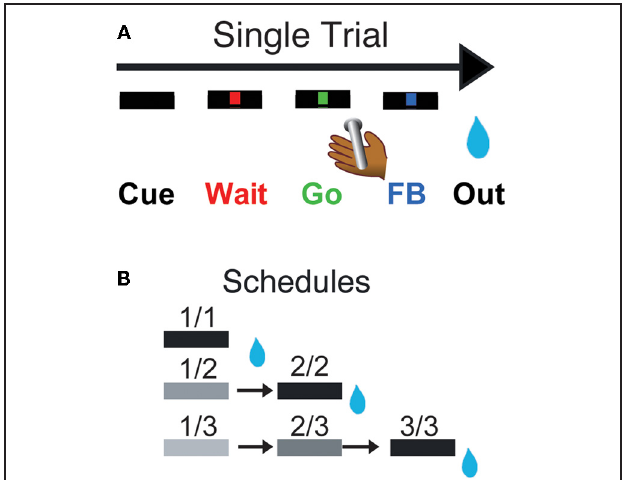
FIGURE 1 | Reward schedule task. Each individual trial (A) begins if the monkeys touch the bar. A cue (rectangle) appears on the monitor in front of them, followed by a red point (wait signal) after 500ms. When the point turns green (Go signal, within 500–1500 ms), the monkey must release the bar within 800ms to complete the trial correctly, in which case the point turns blue (feedback signal). The outcome (juice reward, or not, as a function of the schedule state) occurs 250–550ms later. In the reward schedule task (B) , monkeys must complete either 1, 2, or 3 correct trials to obtain the reward. Once a schedule is completed, another schedule is selected randomly out of the three possible lengths (1, 2, or 3 trials). The progression through the schedules is indicated by the brightness of the cue. All rewarded trials are indicated by a black cue. The fractions indicate the six schedule states, characterized by the trial number (numerator) and the schedule length (denominator). Monkeys must perform a trial correctly to progress through the schedules. If an error is made, monkeys must repeat the erroneous trial but are not require to return to the beginning of the